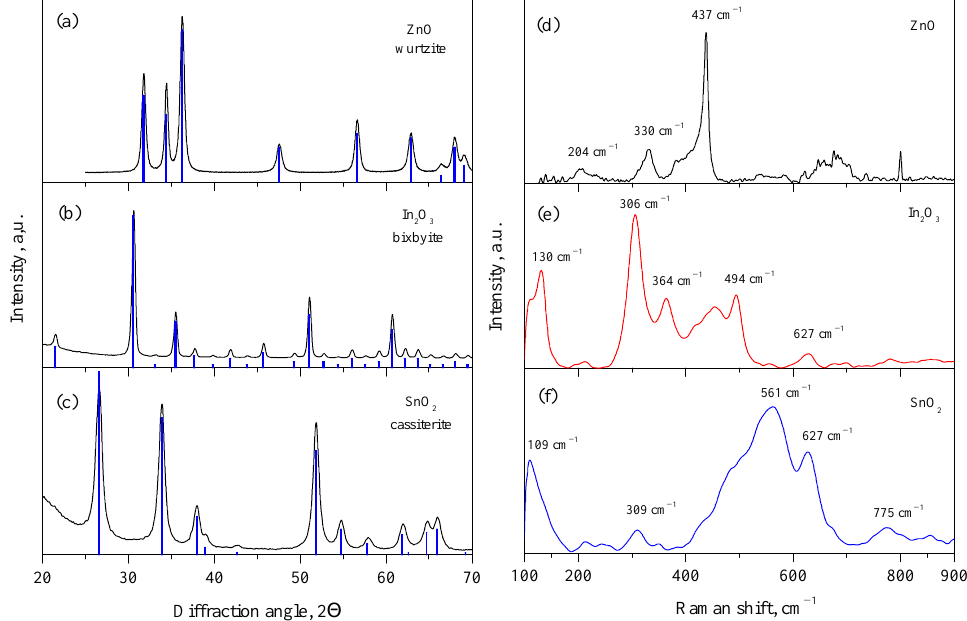
Figure 1. XRD patterns of synthesized nanocrystalline ZnO ( a ), In 2 O 3 ( b ), and SnO 2 ( c ) powders and Raman spectra of synthesized nanocrystalline ZnO ( d ), In 2 O 3 ( e ), and SnO 2 ( f )